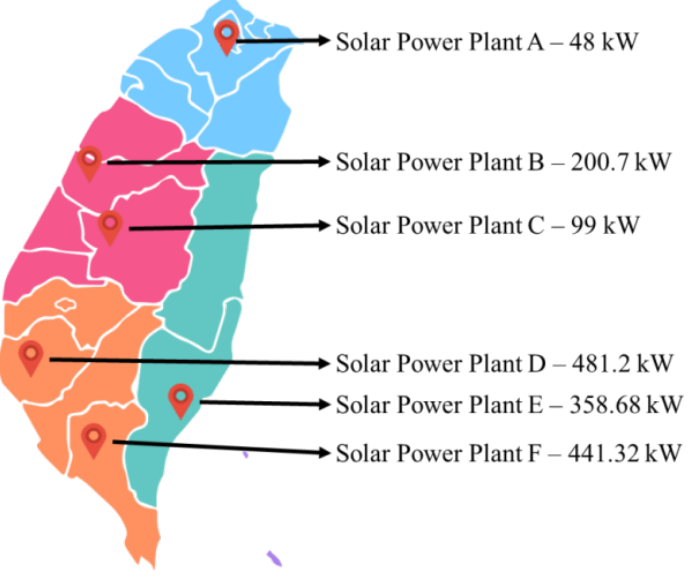
Figure 5. Distribution locations of actual solar PV power generation cases in Taiwan. Table 4. Summary of data record period during one week for six actual solar power plants in Tai- wan.